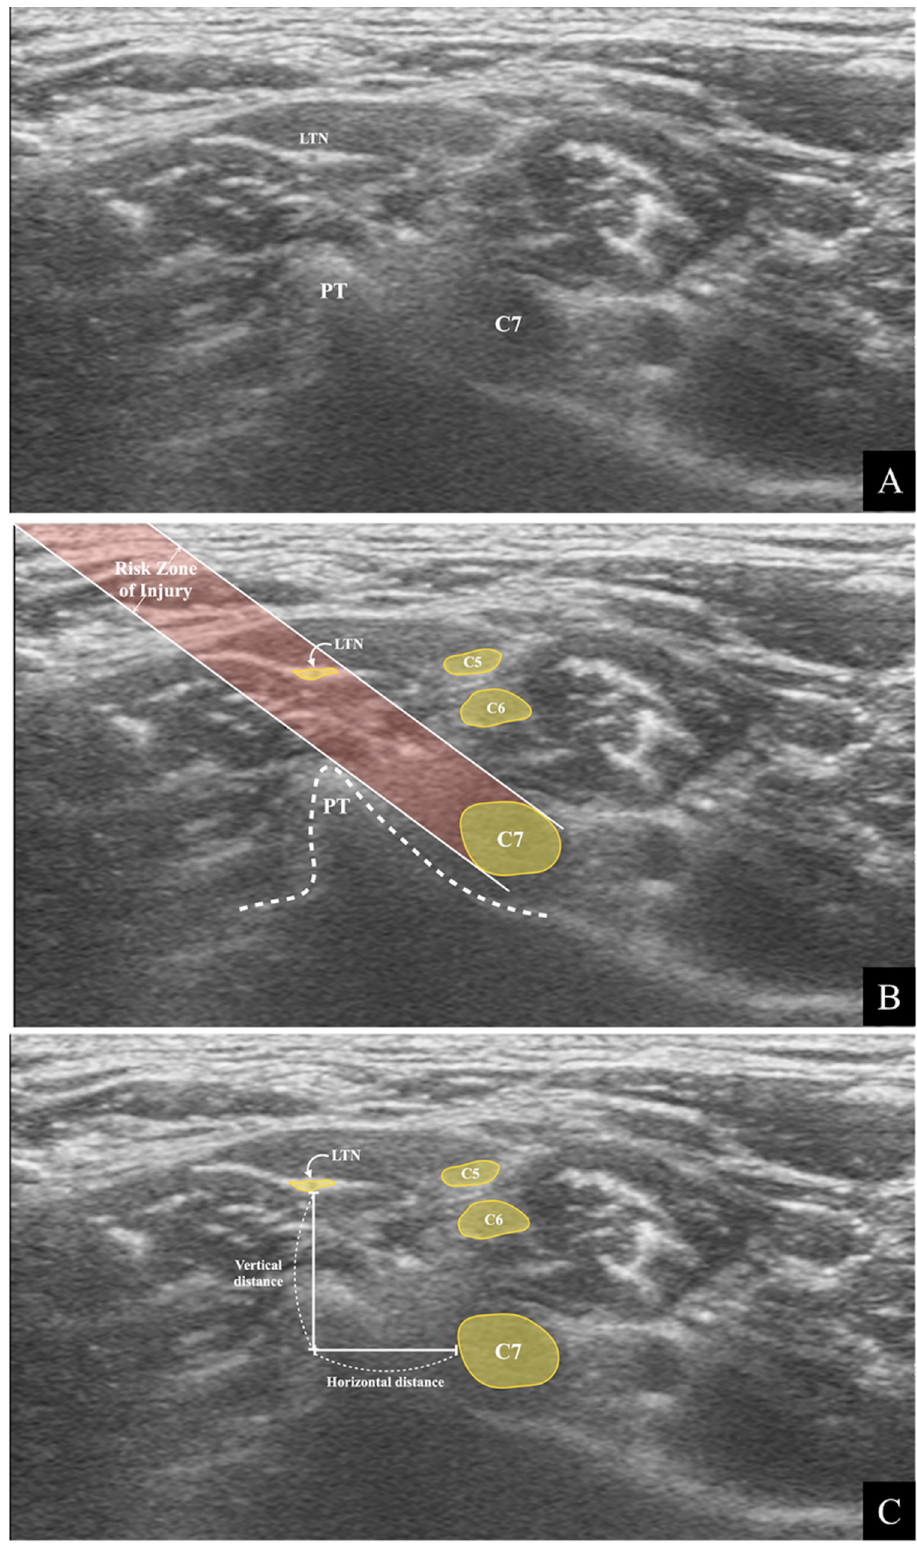
Figure 2. The analysis and measurement of the ultrasound image. ( A ) The ultrasound image captures the C7 transverse process’s posterior tubercle (PT), C7 nerve root, and long thoracic nerve (LTN). ( B ) The simulated analysis of the injury risk of the LTN. Two imaginary lines are drawn, and the area between the lines is the risk zone of injury. ( C ) The distance measurement of the LTN from the C7 nerve root.